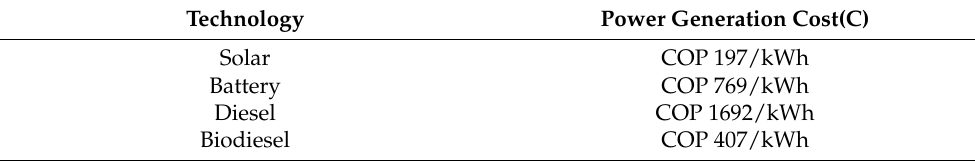
Table 7. Power generation coefficient for Bahía Málaga